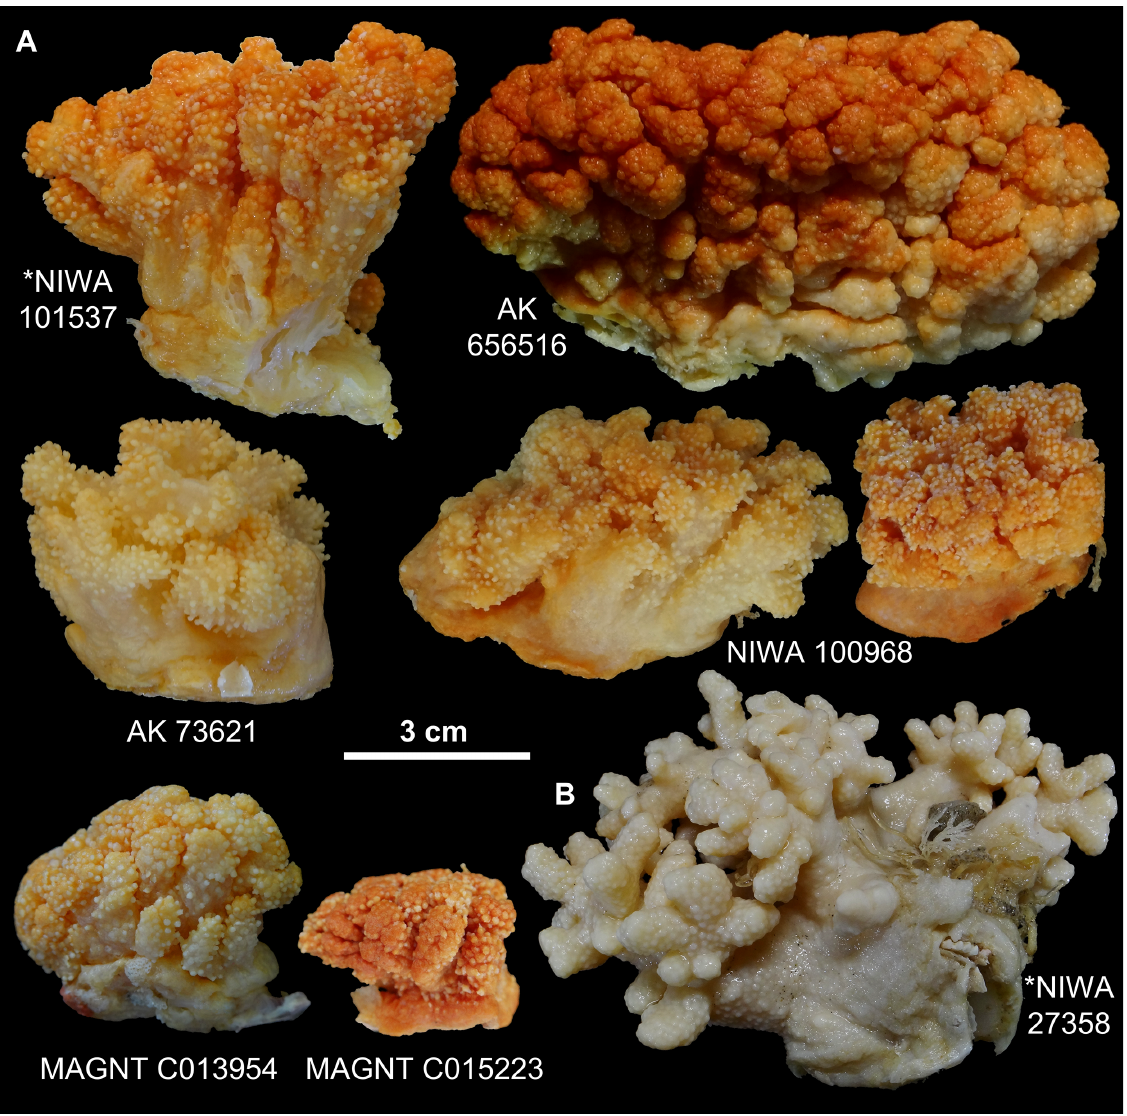
Fig. 24. Preserved specimens. A . Kotatea raekura gen. et sp. nov. B . K. teorowai gen. et sp. nov. Note that lot AK 656516 includes additional fragments that are not shown. * =